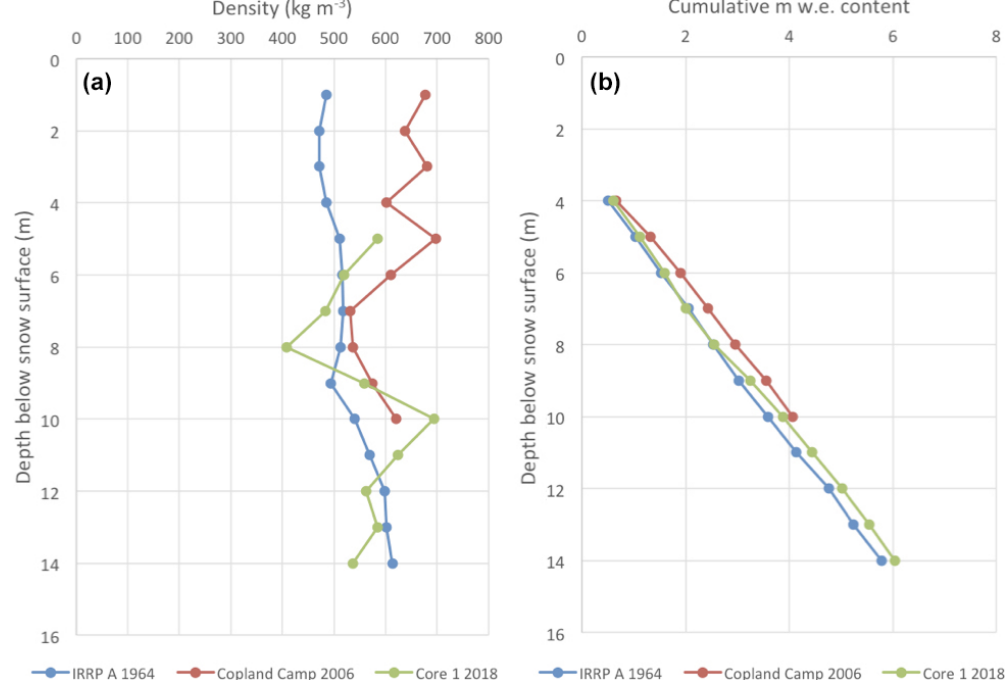
Figure 4. (a) Comparison of densities averaged over 1m segments at IRRP A on 23 July 1964 (Grew and Mellor, 1966; blue), at Copland Camp on 14–17 July 2006 (red), and at Core 1 on 20–24 May 2018 (green). Depth of LSS (i.e., boundary between seasonal snow above and firn below) was 3.28m in 1964, 3.50m in 2006, and 4.22m in 2018; the density data for 2018 begin at the LSS due to the difference in time of year of the measurements compared to the others. (b) Comparison between cumulative w.e. content in the 1964, 2006, and 2018 profiles, starting at the